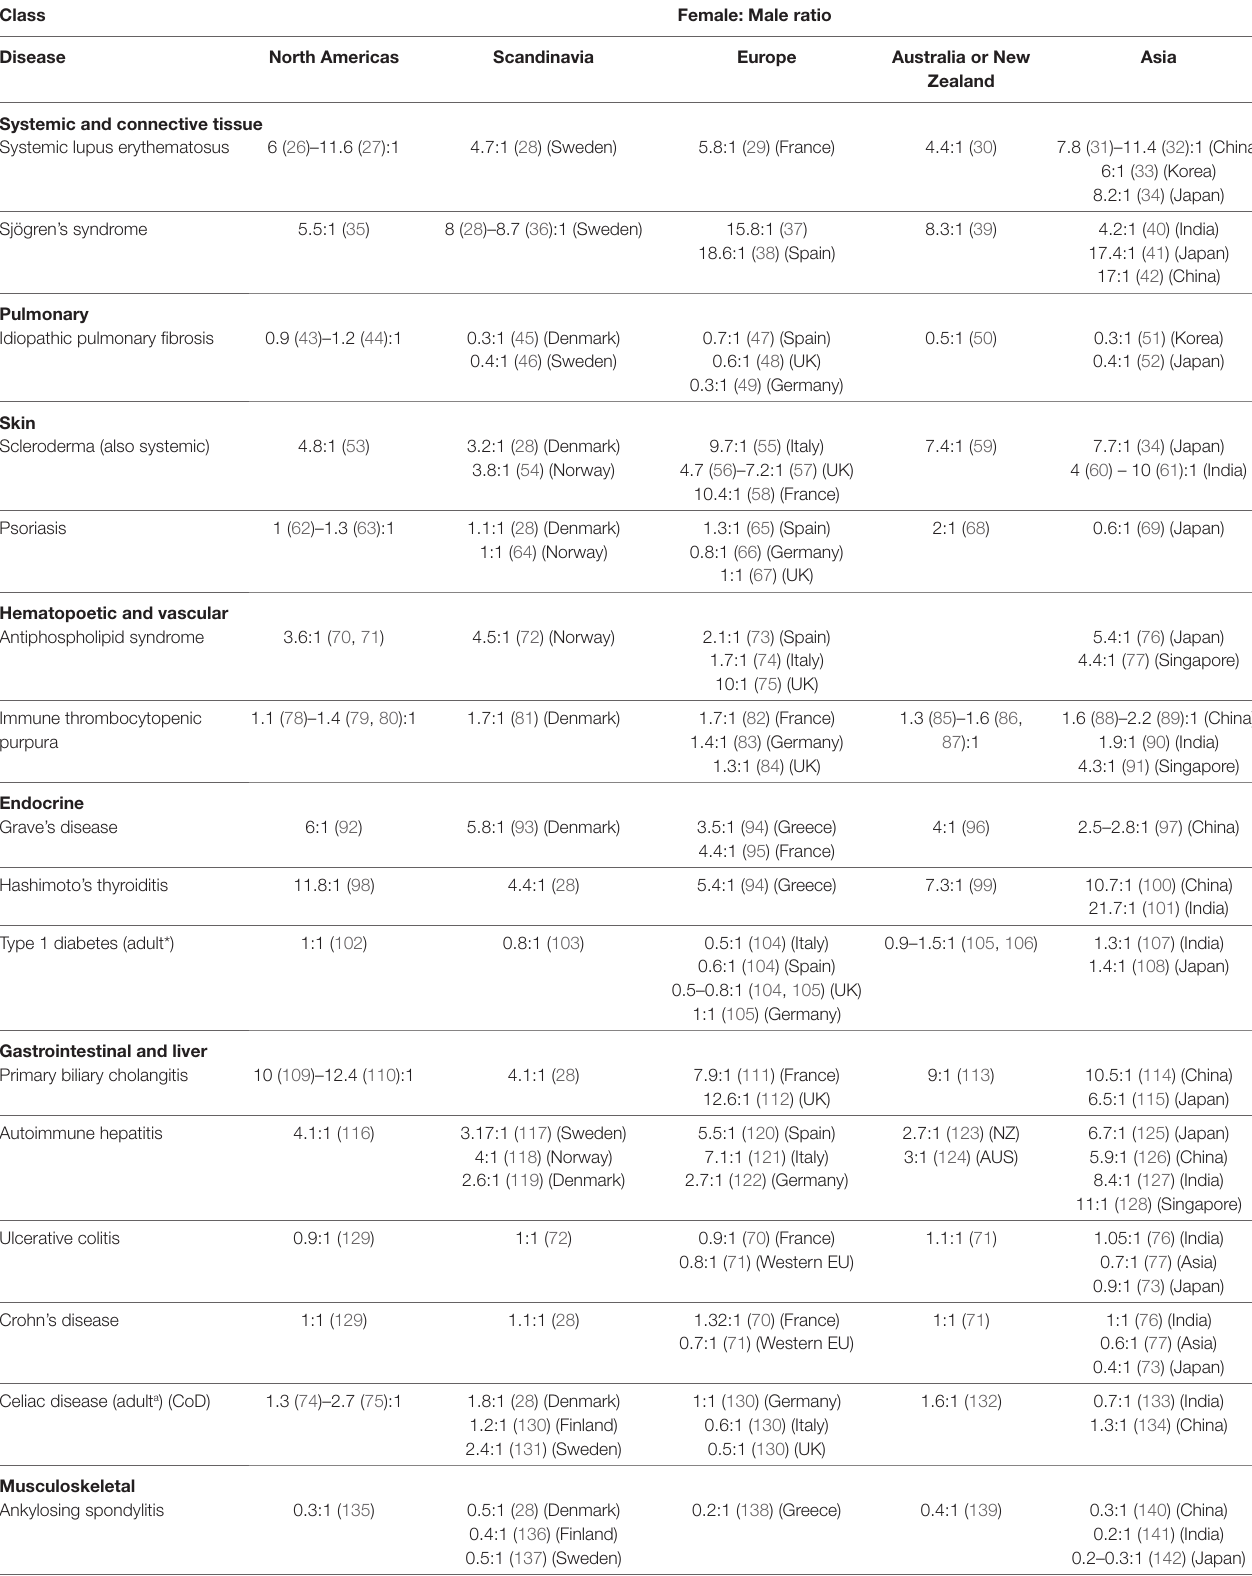
taBLe 2 | Female-to-male ratio of autoimmune diseases (ADs) from different regions of the world. class